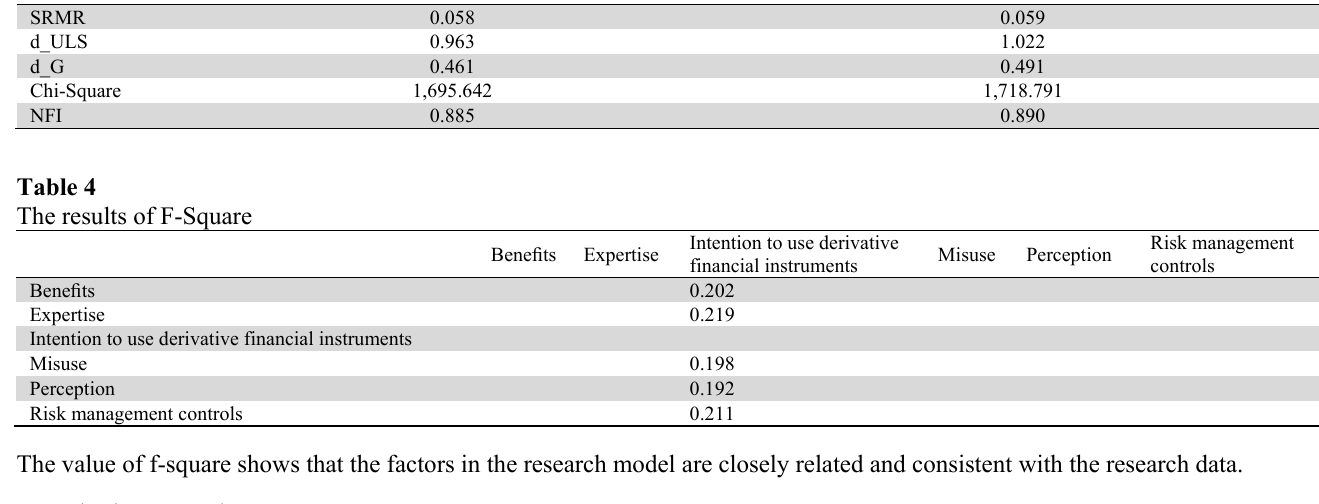
Hypothesis test results